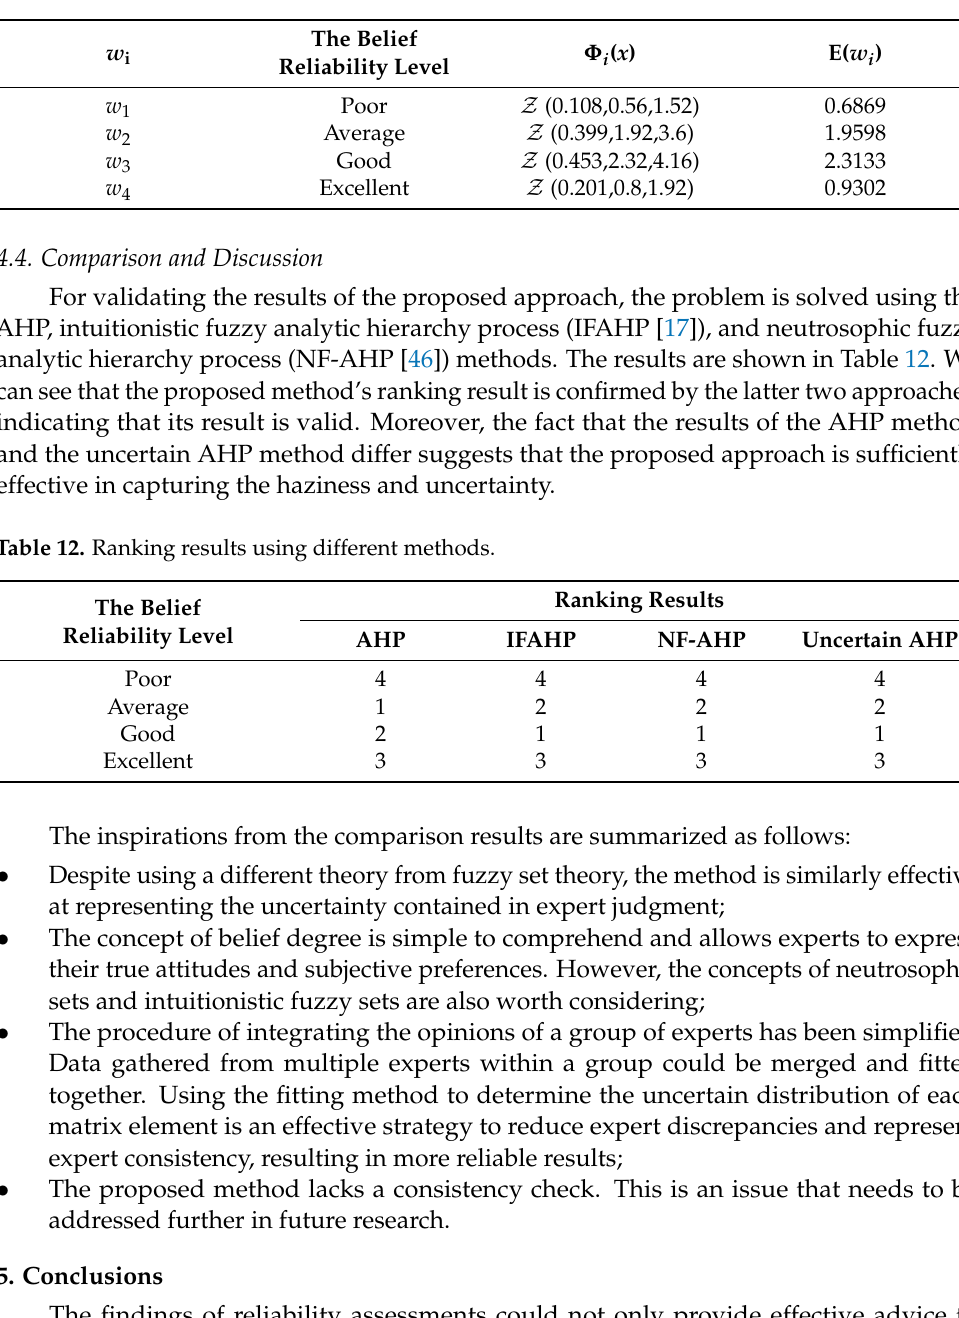
Table 11. The final total score vector.